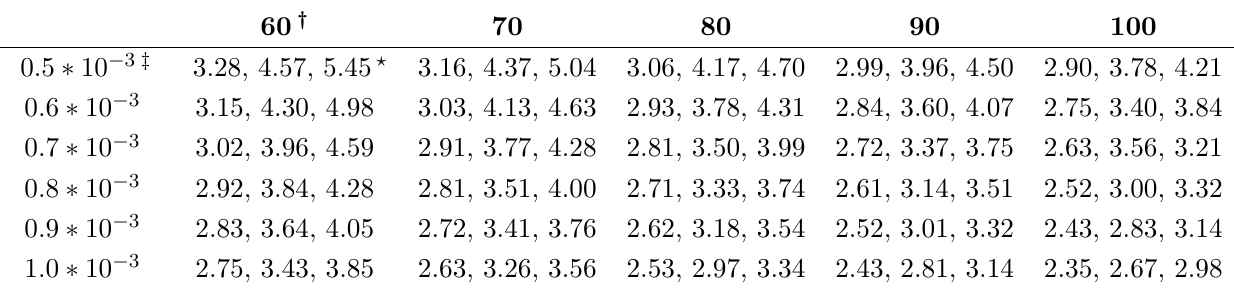
Table 3. Achieved RMSEs over different levels of shadow